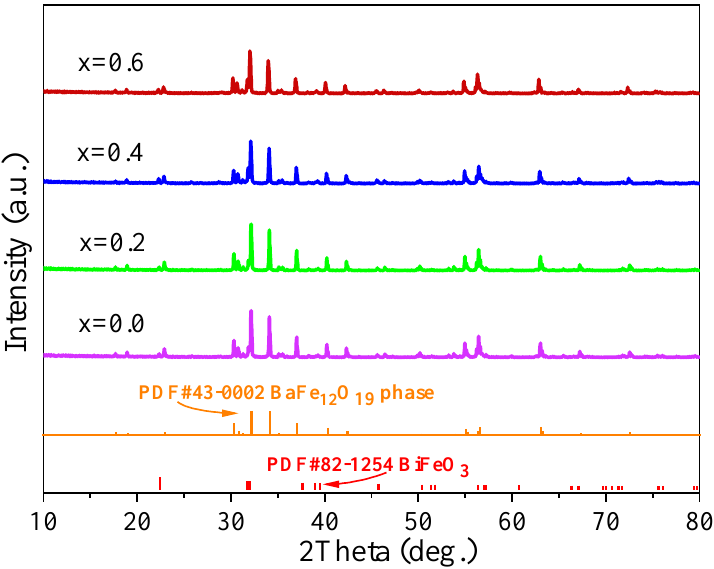
Figure 2. XRD patterns of ferrites with different Sr 2+ ion substitution x values.